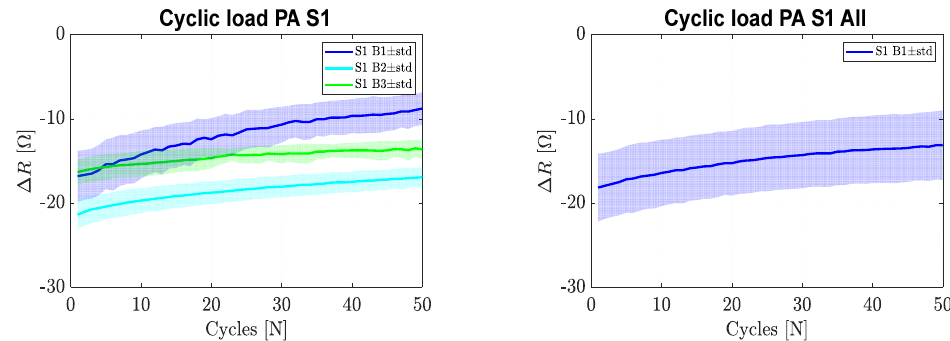
Figure 8. Cyclic force vs. change in resistance in the function of loading cycles (sensor 1 (board sample (B1, B2, B3) ( left ) and average behaviour of all boards ( right )).